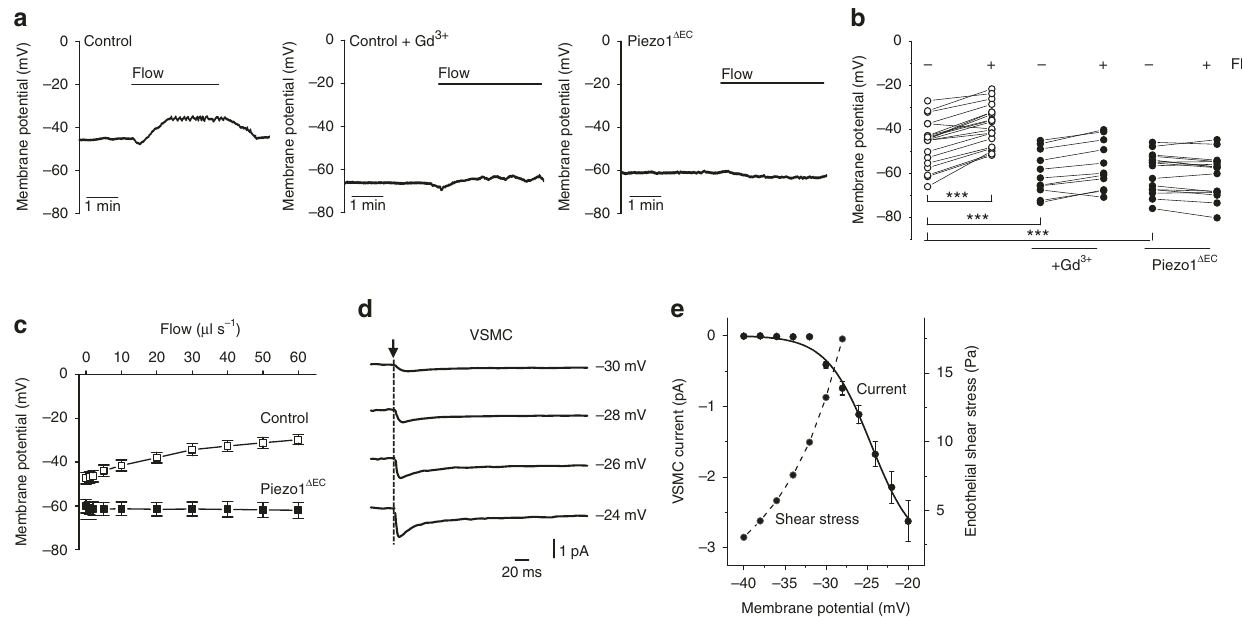
Fig. 5 Ca 2+ channel activation in vascular smooth muscle cells. a , b Membrane potential measurements from freshly isolated endothelium of second-order mesenteric arteries. a Example traces from the control and Piezo1 Δ EC genotypes in the absence of Gd 3+ and the control genotype in the presence of 10 μ M Gd 3+ . Endothelium was exposed to fl ow at 20 μ l s − 1 . b As for a but individual data points for the three independent experiments shown as symbols.